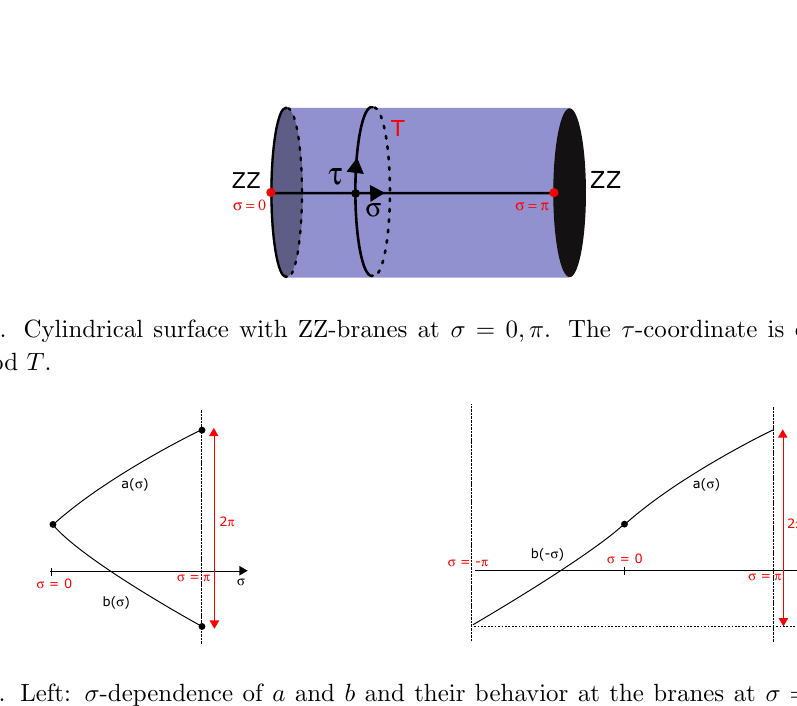
Figure 3 . Left: (cid:27) -dependence of a and b and their behavior at the branes at (cid:27) = 0 and (cid:27) = (cid:25) . Right: the doubling trick allows a description in terms of a single function f ( (cid:27)